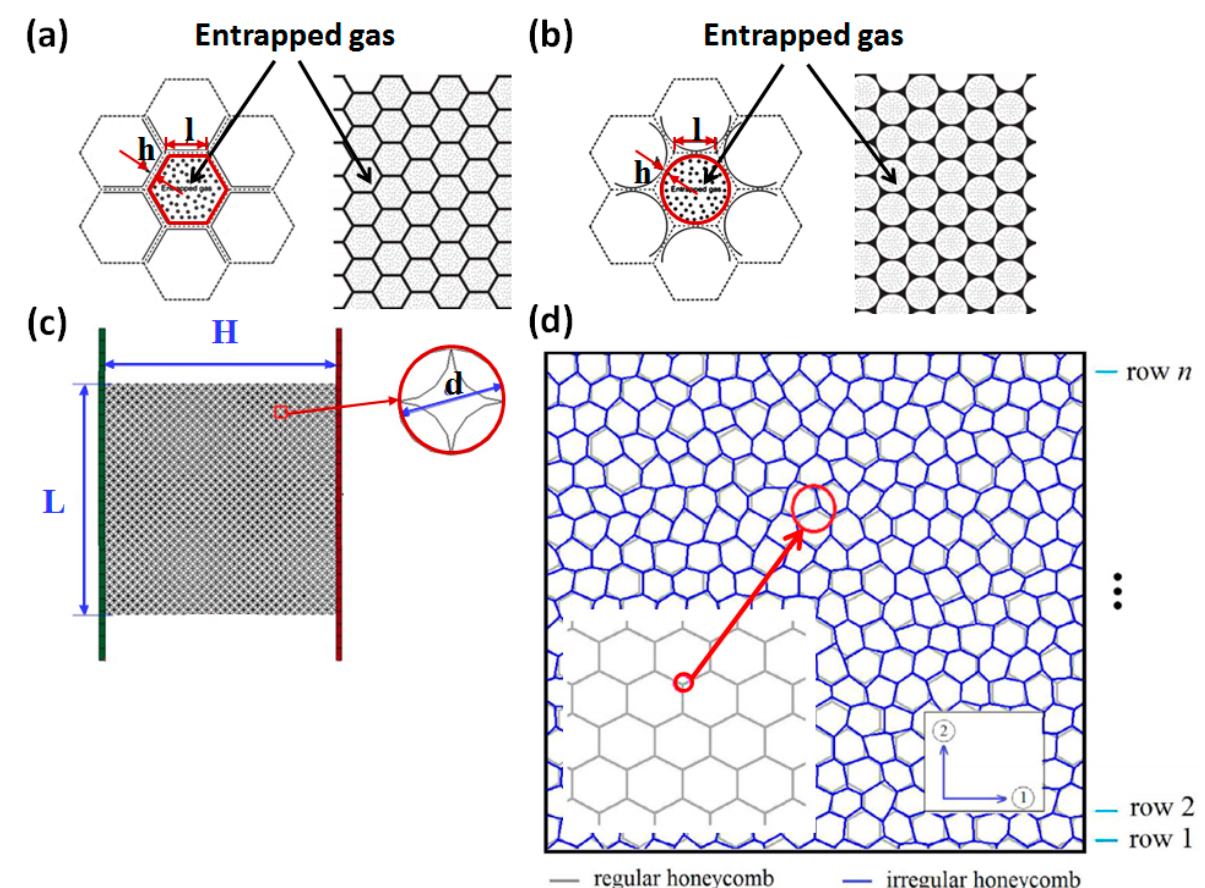
Figure 7. 2D multi-cell models: ( a ) hexagonal-cell model [120]; ( b ) circular-cell model [120]; ( c ) circle arc (c-a) model [119]; ( d ) irregular hexagonal-cell model [122].